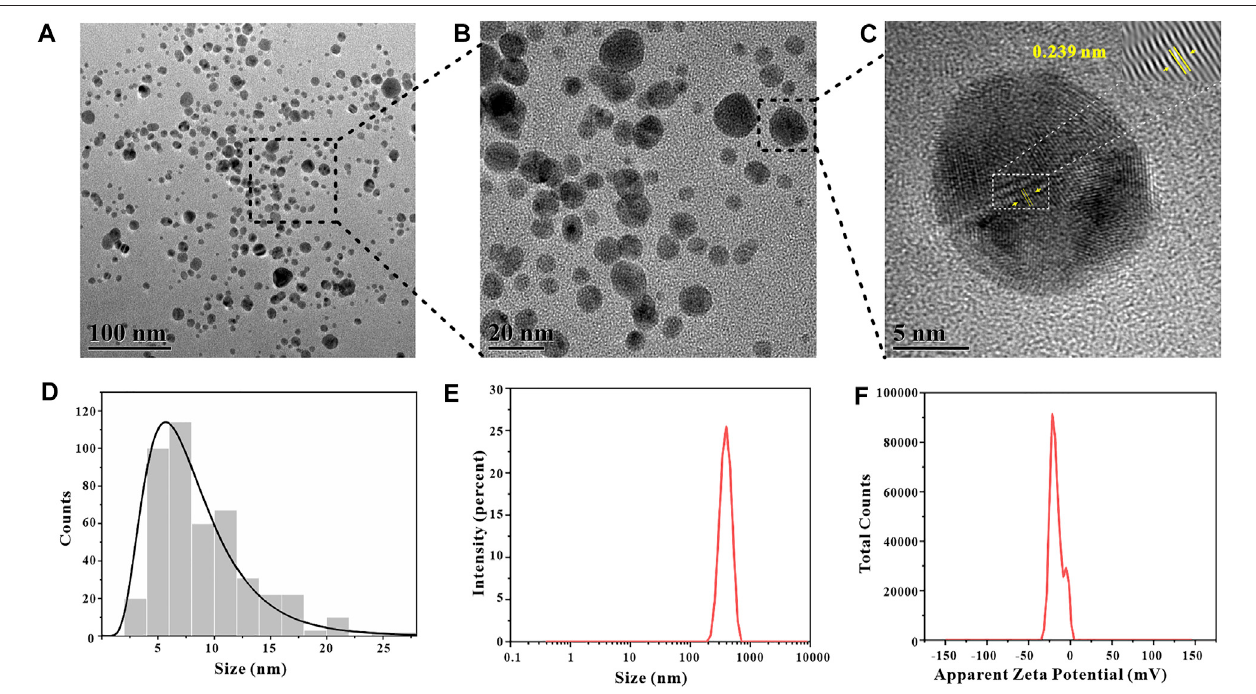
FIGURE 8 | Characterization data of GO-AgNPs synthesized under optimal conditions, TEM images (A,B) , B is the local magni fi cation of A, HRTEM image (C) , particle size distribution of AgNPs (D) , particle size distribution of GO-AgNPs (E) , Zeta potential of GO-AgNPs (F) .